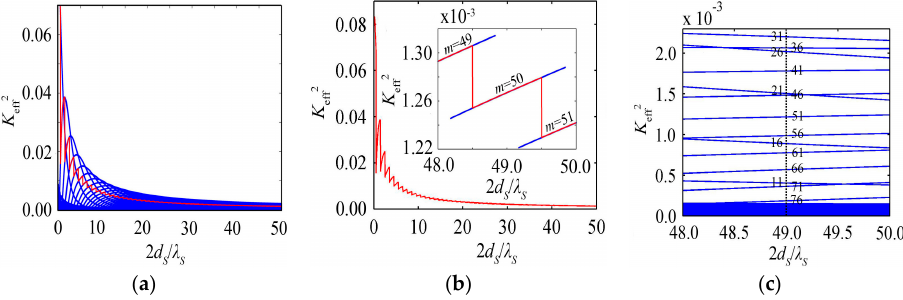
Figure 3. The HBAR consisting of ZnO 1.05 μ m /Sapphire; ( a ) The variation curve of K eff2 with the substrate thickness; ( b ) The variation curve of K eff2 at the frequency closest to f 0 with the substrate thickness; ( c ) The partial enlarged drawing of Figure 3a.